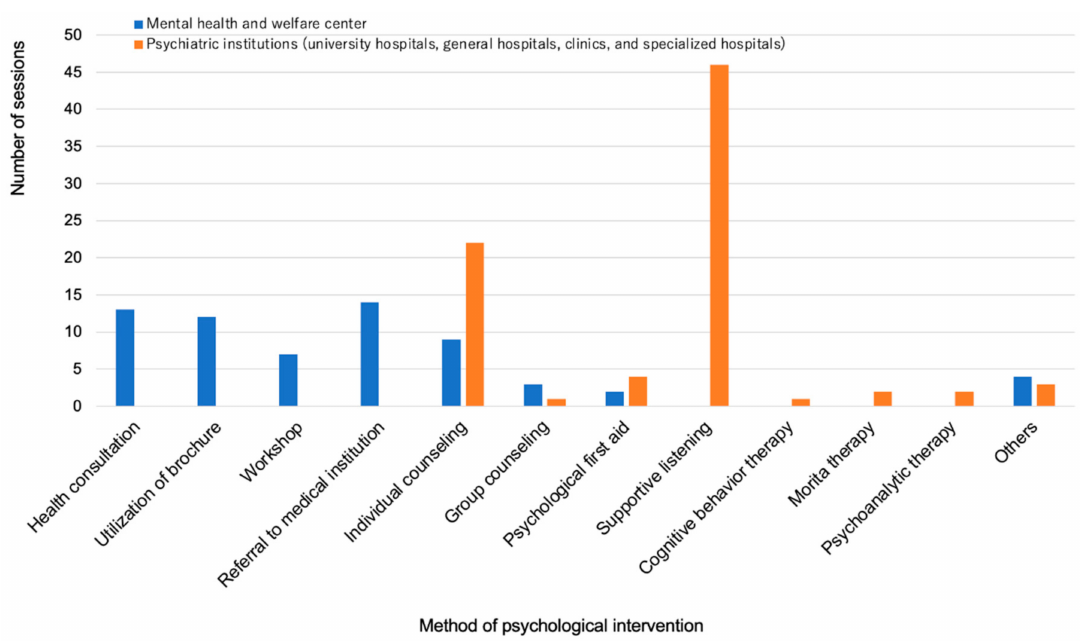
Figure 7. Number of sessions according to psychological intervention